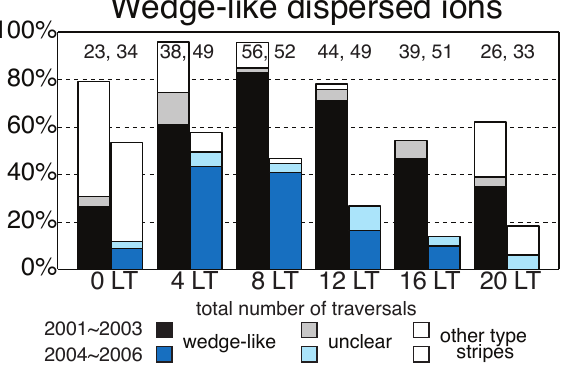
Fig. 4. Observation frequency (%) of detecting clear wedge-like dispersed ions at different local time (LT) sectors (22–02LT, 02– 06LT, 06–10LT, 10–14LT, 14–18LT, and 18–22LT) observed by Cluster-4 CIS/CODIF during 2001–2003 and 2004–2006. Number at the top of each bar is the total number of traversals in each 4h